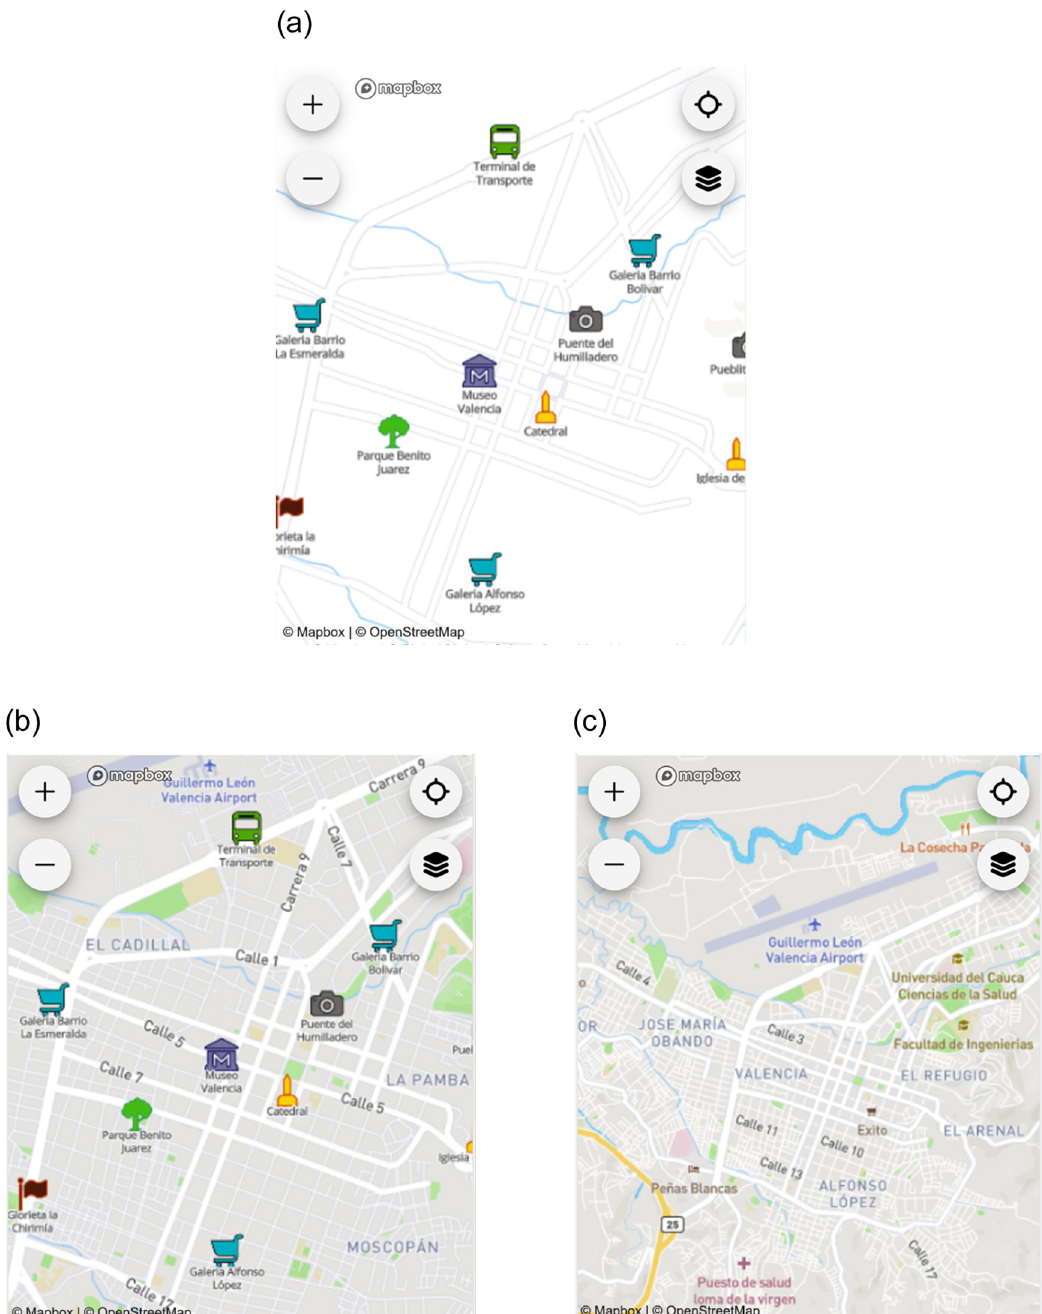
Fig 5. Types of base maps with a) Landmark map, b) Simple map, and c) Mapbox Streets base map (note that the figures use map data from Mapbox and OpenStreetMap and their data sources; also see mapbox.com/about/maps and openstreetmap.